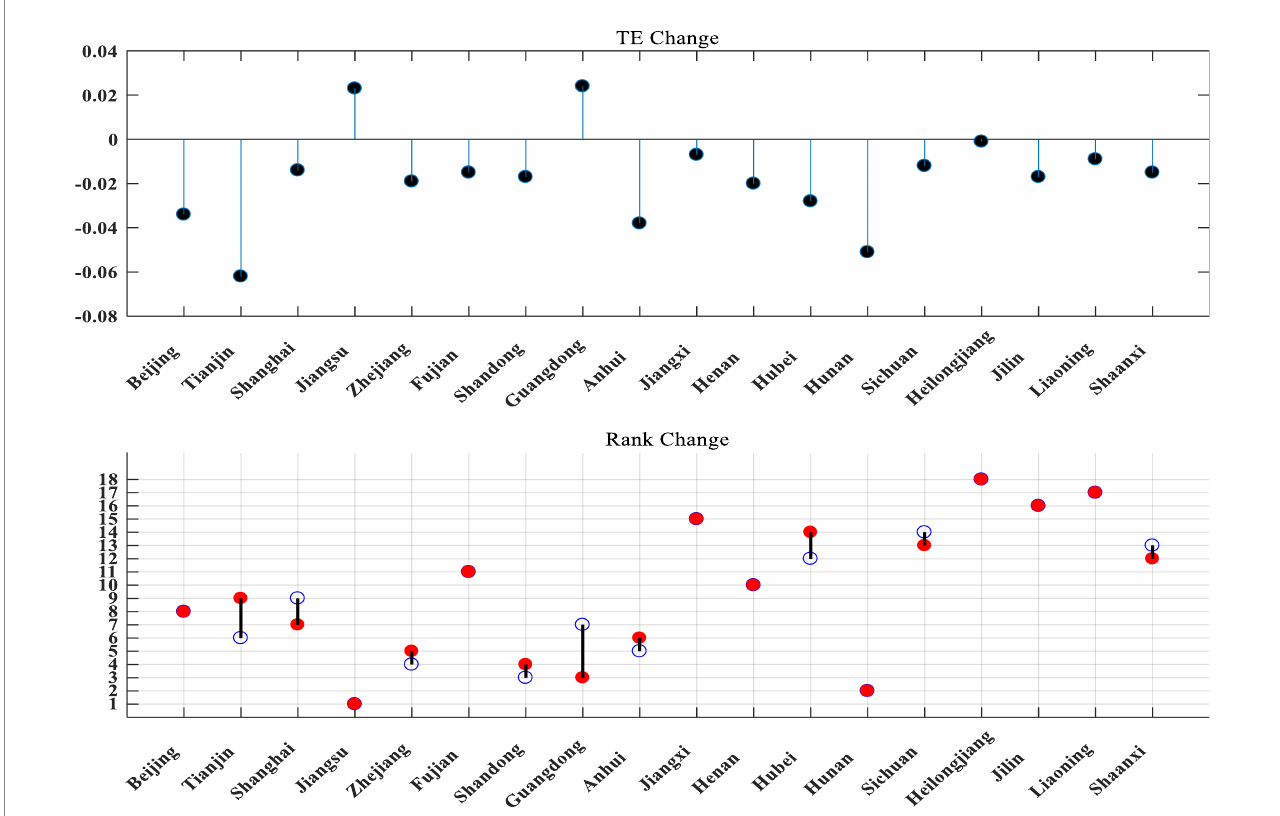
FIGURE 4 Three stages of TE change in technology and finance in strategic emerging industries. The blue hollow circles in the chart are the first stage rankings, the red solid circles are the third stage